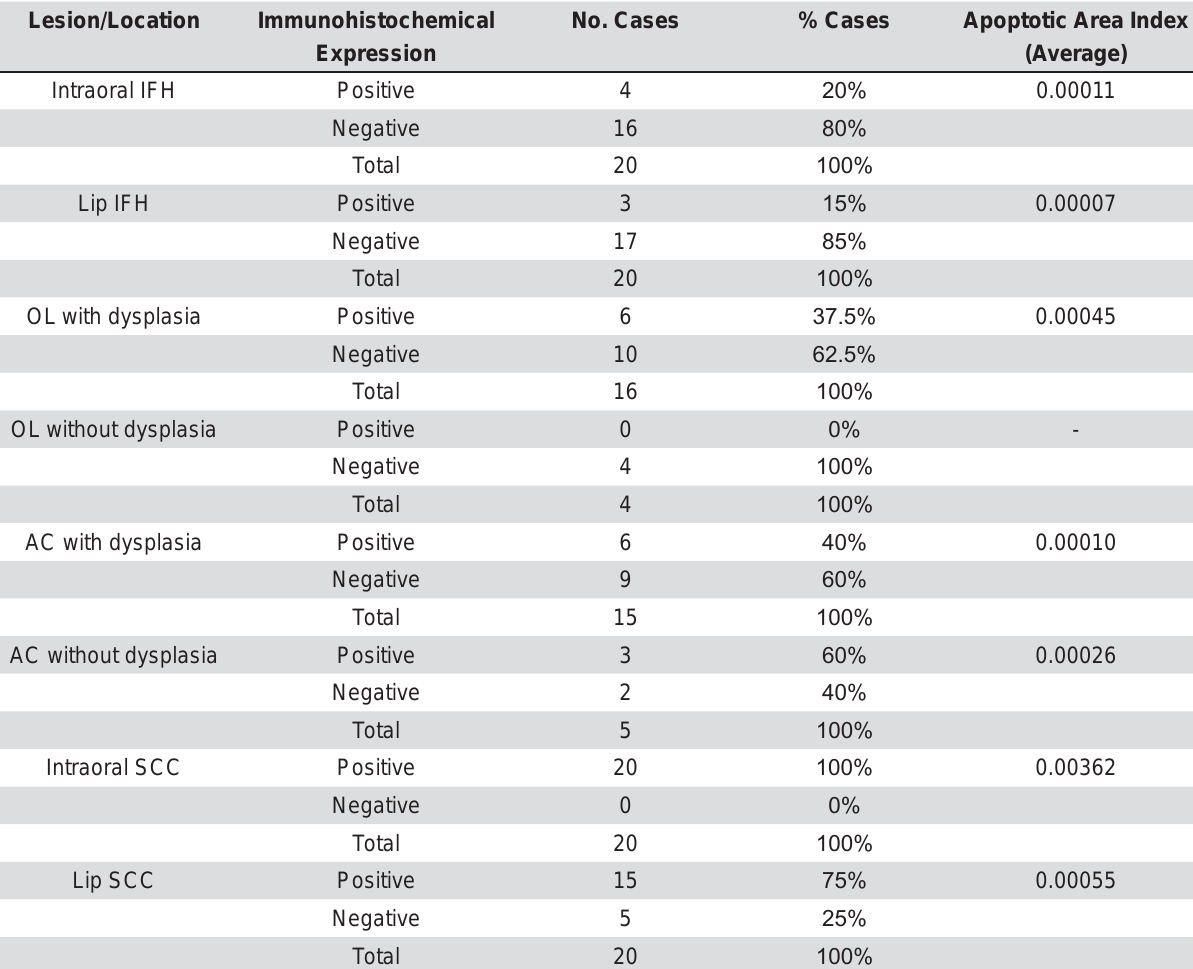
Table 1- Immunohistochemical expression of cleaved caspase-3 in intraoral and lip IFH, OL, AC, and intraoral and lip SCC